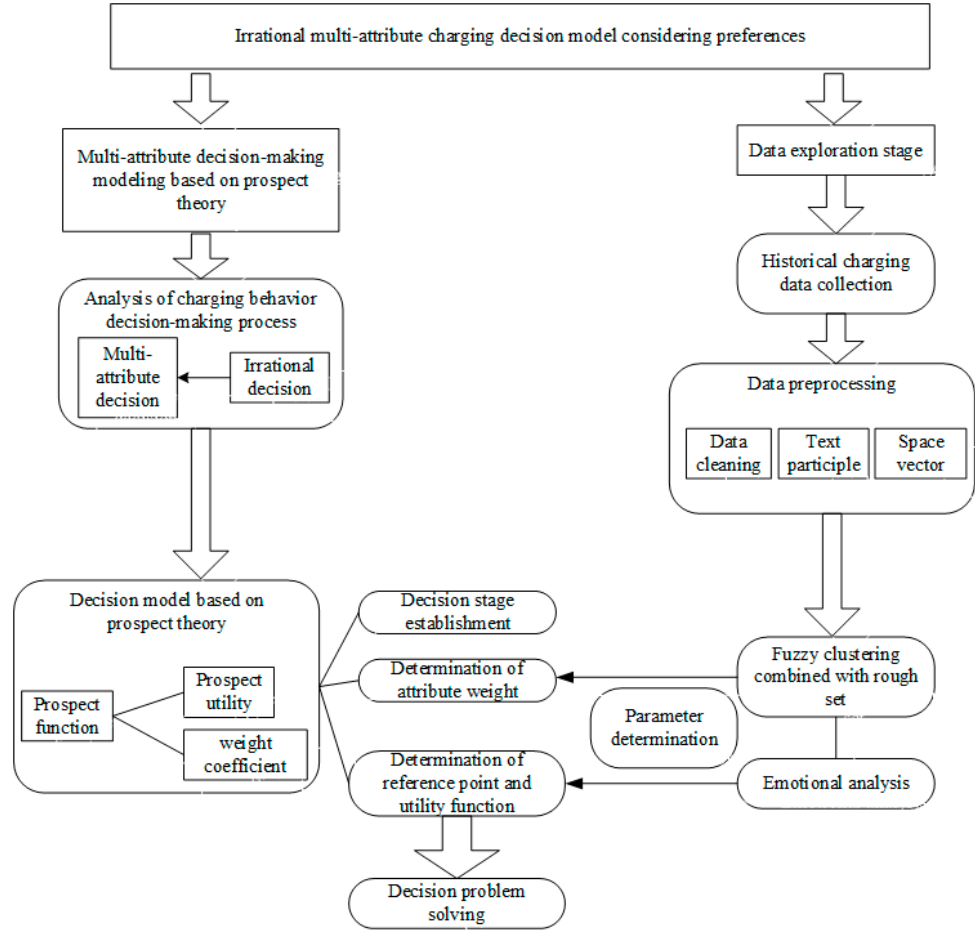
Figure 3. The framework of irrational multi-attribute charging decision model consider- ing